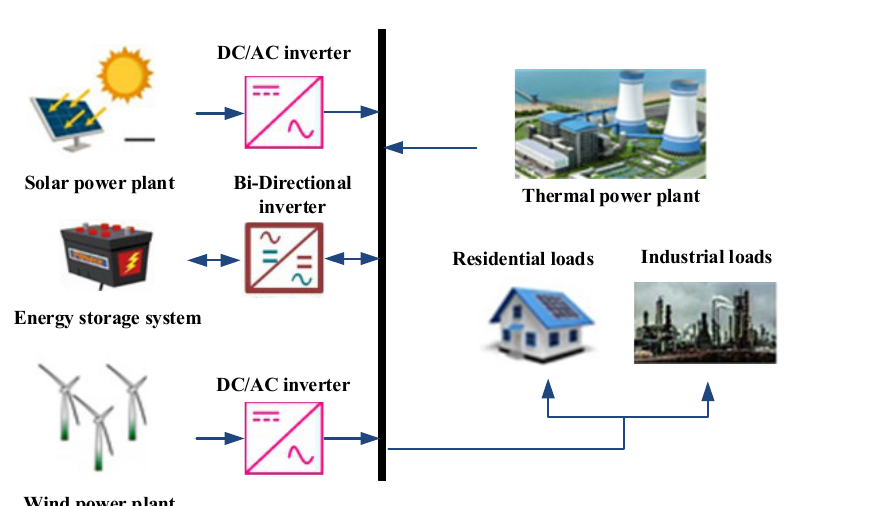
Figure 2. Dynamic structure of the microgrid. 2.2. B. Structure of the Understudy Microgrid As presented in Figure 2, for obtaining inertia power, ESS is implemented, where the dynamics of VIC loop is emulated utilizing a PLL, inertia control scheme, and ESS model based on inverter. The inertia control and ESS model dynamic structures are described in Figure 3a, in which the inertia control is represented by a derivative control approach for changing the shared active power to the system set point according to RES penetration through generating the RoCoF. However, in order to provide the real features of the ESS by reducing the effect of noise that arises because of PLL utilization for frequency measurement, a low-pass filter is applied with the derivative inertia control.